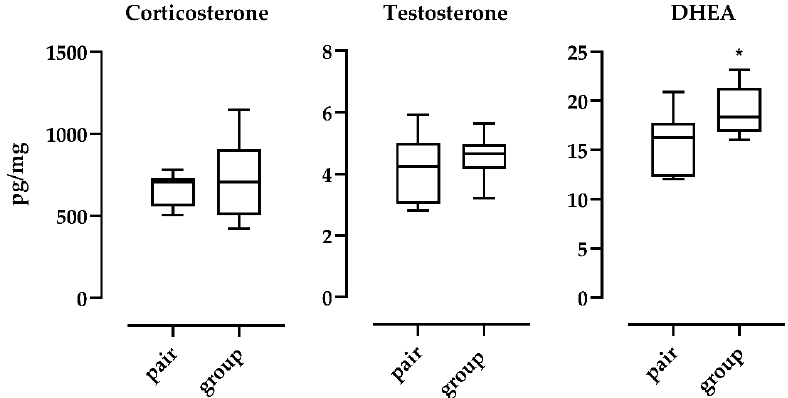
Figure 1. Linear regression model between the three hair hormone concentration (pg/mg) and age